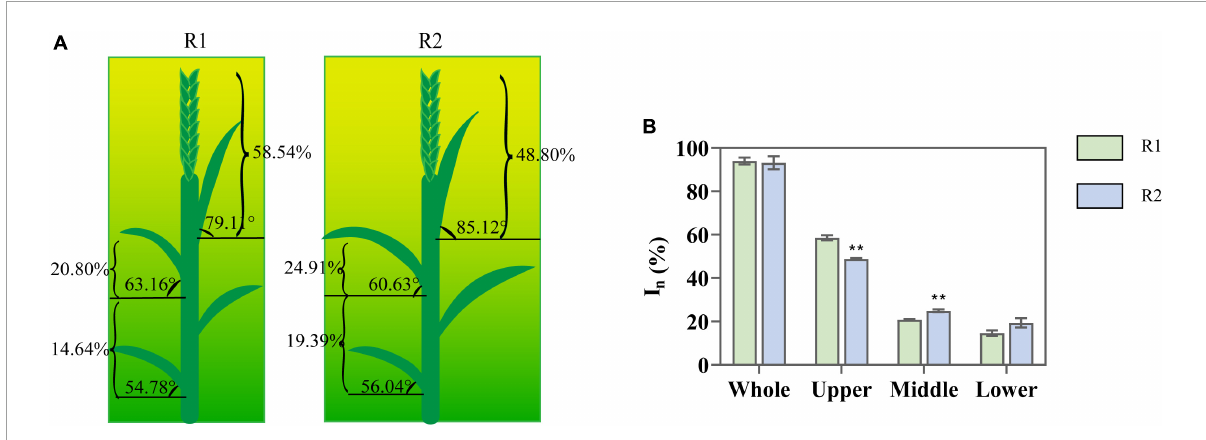
FIGURE1 Change in leaf angle and the light interception at anthesis under different row spacing treatments. (A) The schematic representation: arc represents leaf angle; brace represents the values of photosynthetically active radiation (PAR) interception; (B) The PAR interception in the upper-, middle-, and lower-canopy layer. Results presented as mean ± standard deviations (SD); Error bars represent SD. Significant differences marked by asterisks (** p < 0.01).